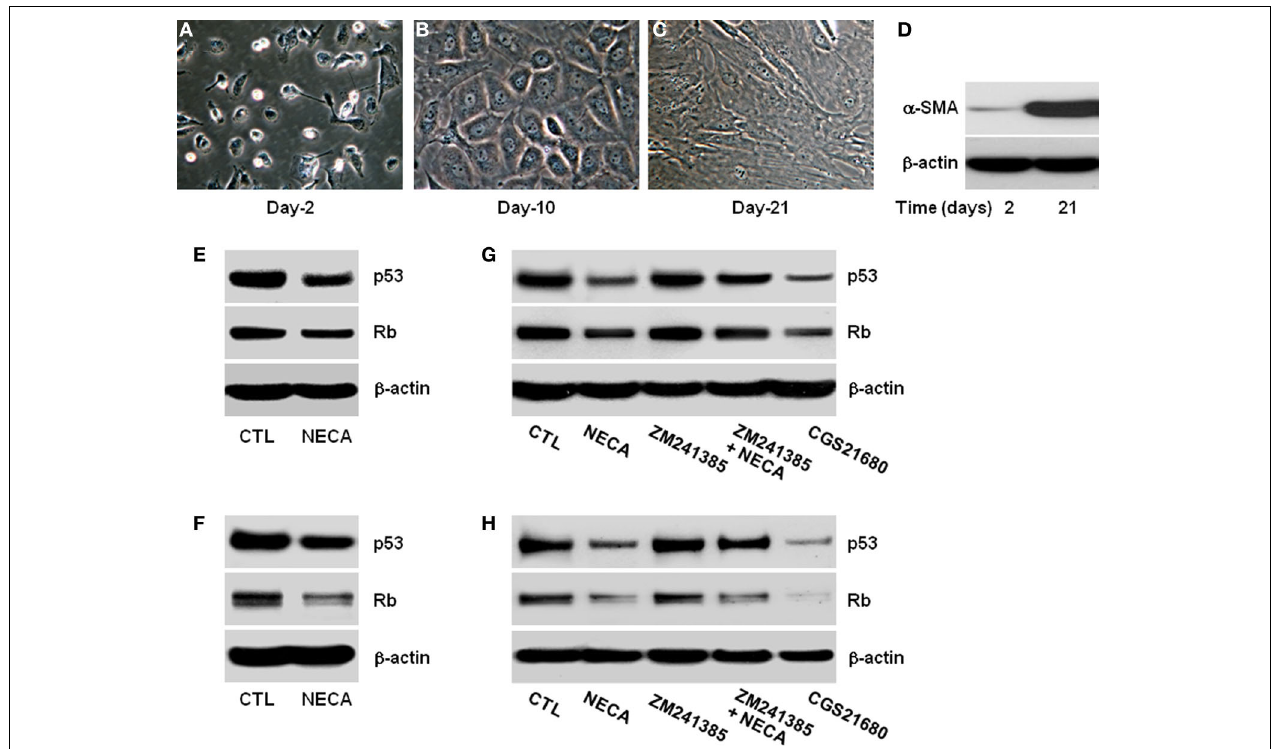
FIGURE 1 | Pan-adenosine receptor agonist (NECA) down regulates p53 and Rb level in HSC through adenosine receptor A 2A signaling. Morphological characteristics of primary rat HSC were recorded for 2–21 days in the culture and shown (A) at day-2 in quiescent stage, (B) at day-10 in activated stage, or (C) at day-21 in highly activated stage. (D) Western blot shows expression of α -smooth muscle actin ( α -SMA) at day-2 and at day-21 as a marker of activated primary HSC. Human HSC